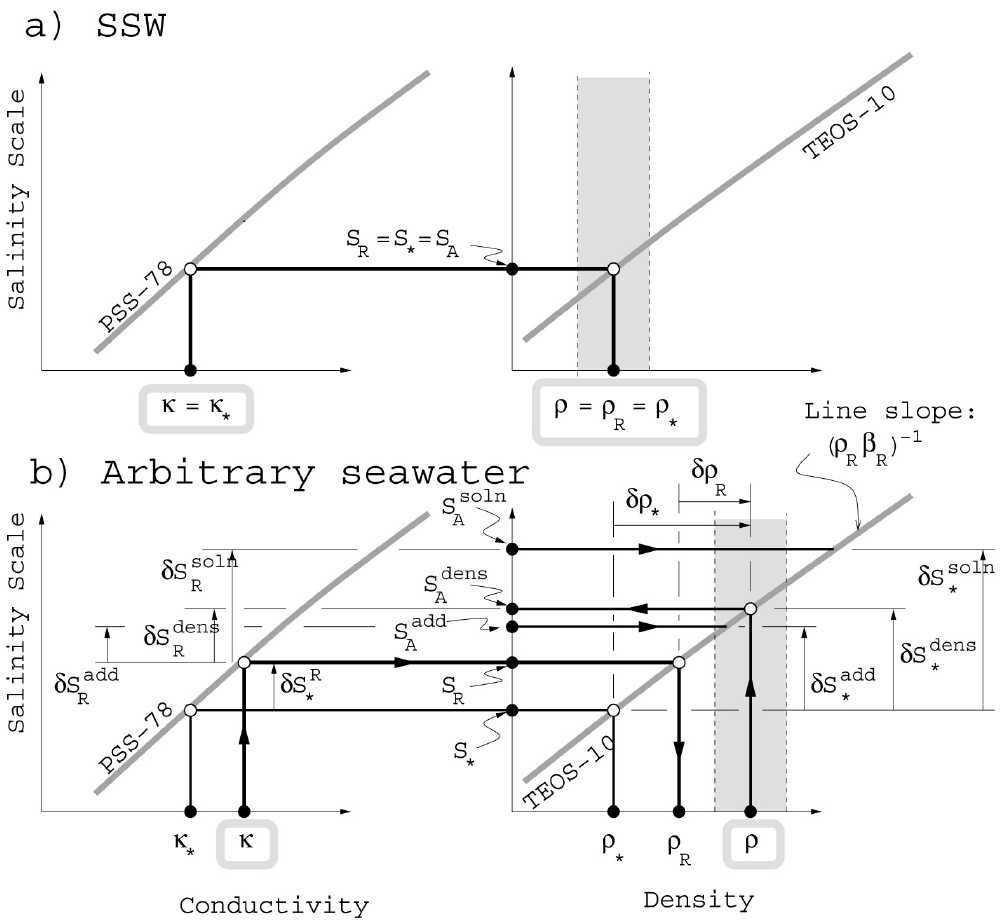
Fig. A1. This figure schematically shows the relationships between different variables used to characterize seawater. (a) For SSW. The estimate S R of the Absolute Salinity S A is used to define a conductivity/salinity relationship (schematically shown as the scaled PSS-78 curve on the left hand graph), and a density/salinity relationship (schematically shown as the TEOS-10 curve on the right hand graph). The vertical gray bar indicates the uncertainty range of measured densities around the TEOS-10 prediction. (b) For arbitrary seawater, composed of a preformed SSW component with absolute salinity S ∗ , plus a composition anomaly. Observed values are indicated by labels outlined in gray along the horizontal axes. The observed conductivity κ is related to a Reference Salinity S R and a reference density ρ R 6= S R . Estimates of mass using relationships developed for SSW. However, the observed density ρ is related to the Density Salinity S dens A fraction salinities S add and S soln directly determined from the full chemical composition are respectively defined based on whether the mass A A of anomalous solutes are accounted for before or after their addition to the Preformed Salinity. The difference between the two estimates reflects the effects of equilibrium chemistry within seawater, which converts some H 2 O into the chemical forms comprising the solute. Empirically, the relationship in the ocean between S add and measured densities ρ can be described, within typical observational error, by A TEOS-10. This is not true in general for the relationship between S soln and ρ A